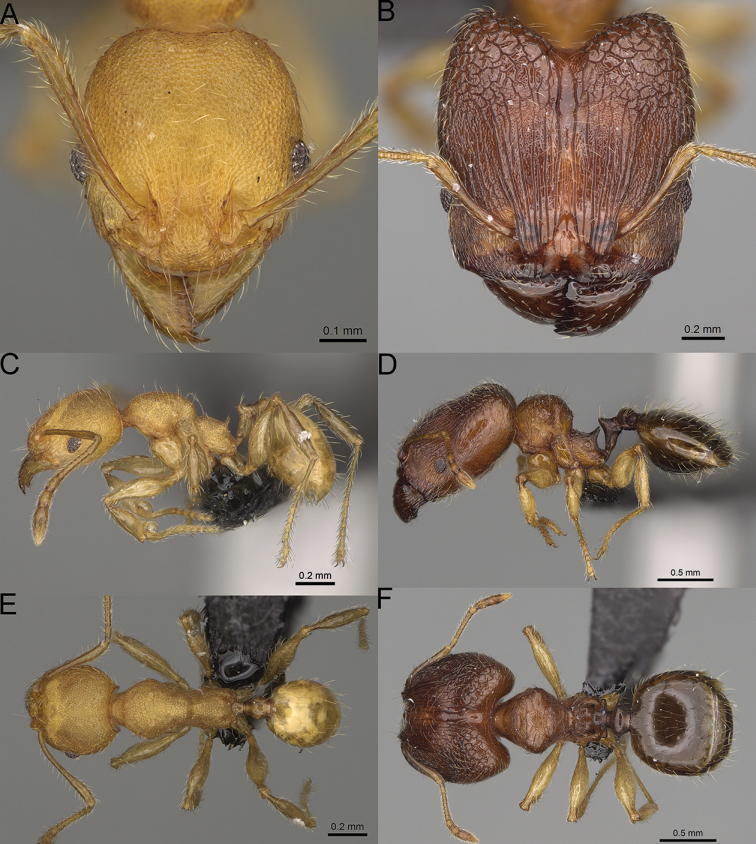
Pheidole
vatovavensis sp. nov., full-face view (A), profile (C), and dorsal view (E) of paratype minor worker (CASENT0923179) and full-face view (B), profile (D), and dorsal view (F) of holotype major worker (CASENT0060282).